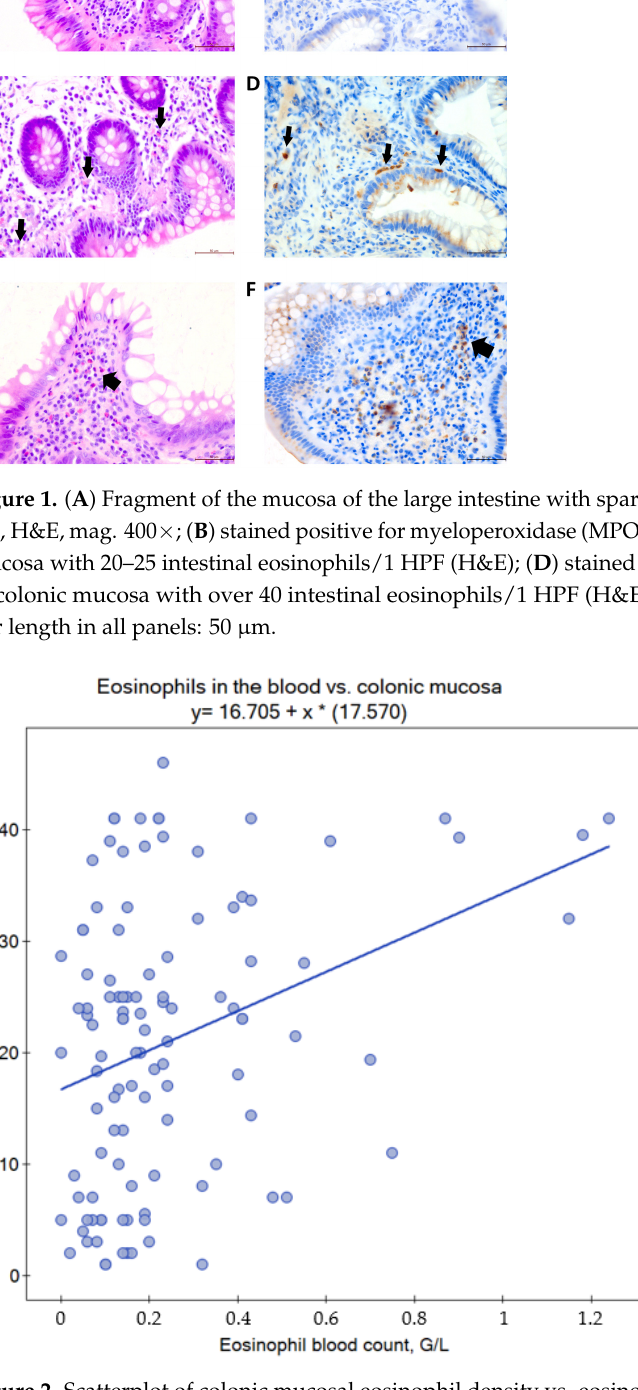
Figure 2. Scatterplot of colonic mucosal eosinophil density vs. eosinophil blood count in 109 children who underwent diagnostic colonoscopy. Some points may overlap. HPF—high-power field. Asterisk (*) indicates multiplication. Table 2. Correlations between colonic mucosal eosinophil density and other parameters in all the subjects and in selected subgroups. Spearman’s rho (r) is presented, along with 95% confidence in- tervals (95% CI). p values < 0.05 are indicated with asterisk (*). Assessed Correlation, in All Subjects r 95% CI p colonic mucosal eosinophil density vs.